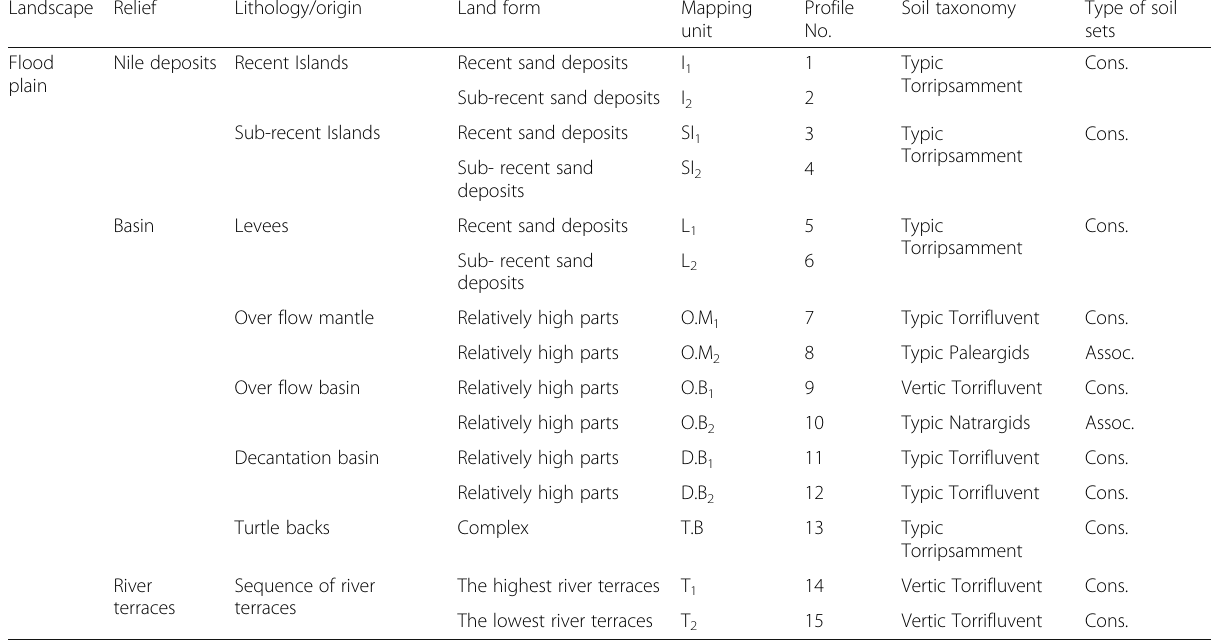
Table 6 Physiographic and soil map legend of the investigated area Landscape Relief